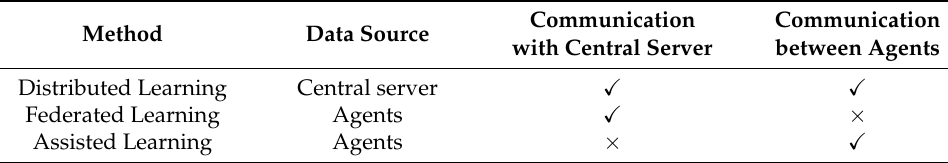
Table 1. Comparison of distributed, federated, and assisted learning.